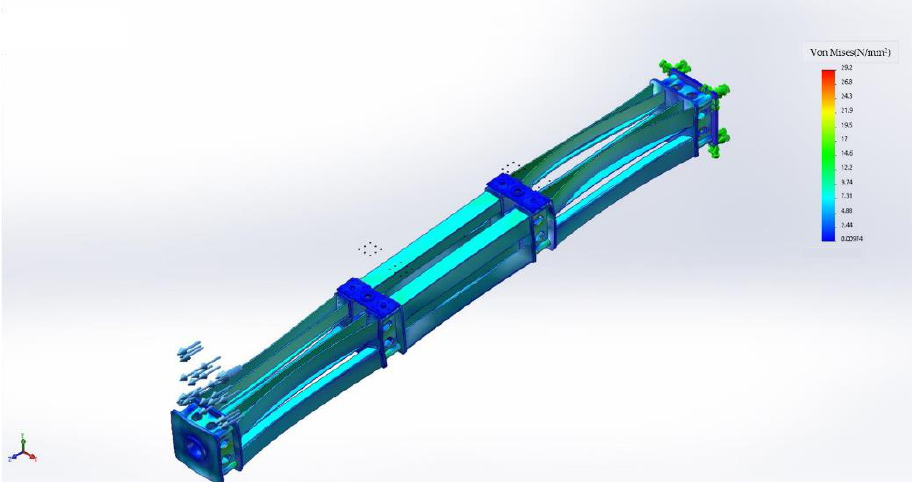
Figure 5. Stress cloud diagram under axial load.